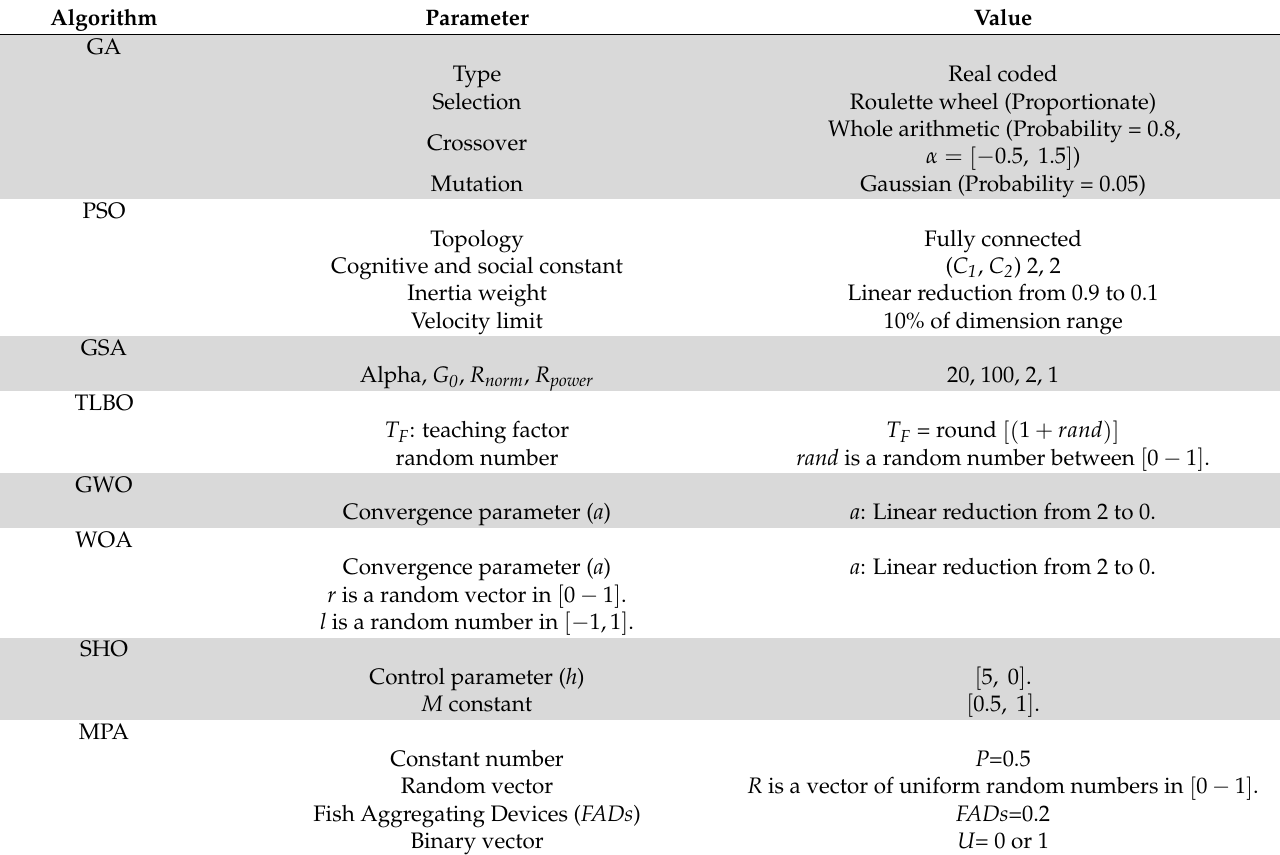
Table 2. Parameter values for the comparative